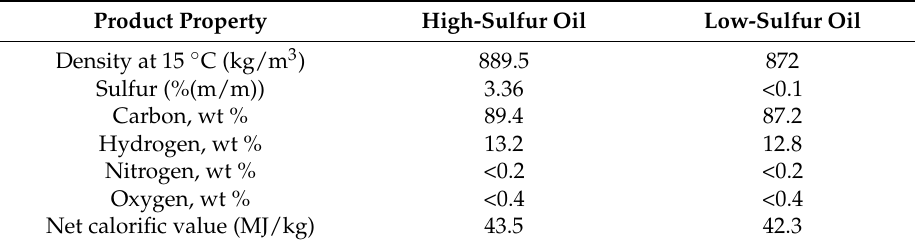
Table 2. Selected properties of the different types of